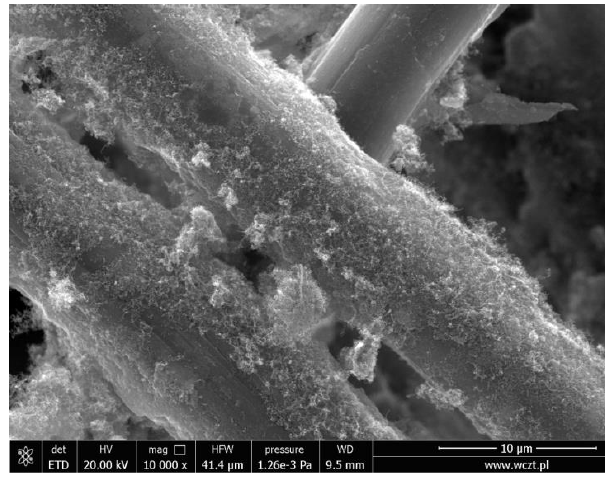
Fig. 5. Cress growth results on an ordinary substrate without CNT (on the top) and on a substrate made of carbon fiber – CNT composite (Nanoveil; on the